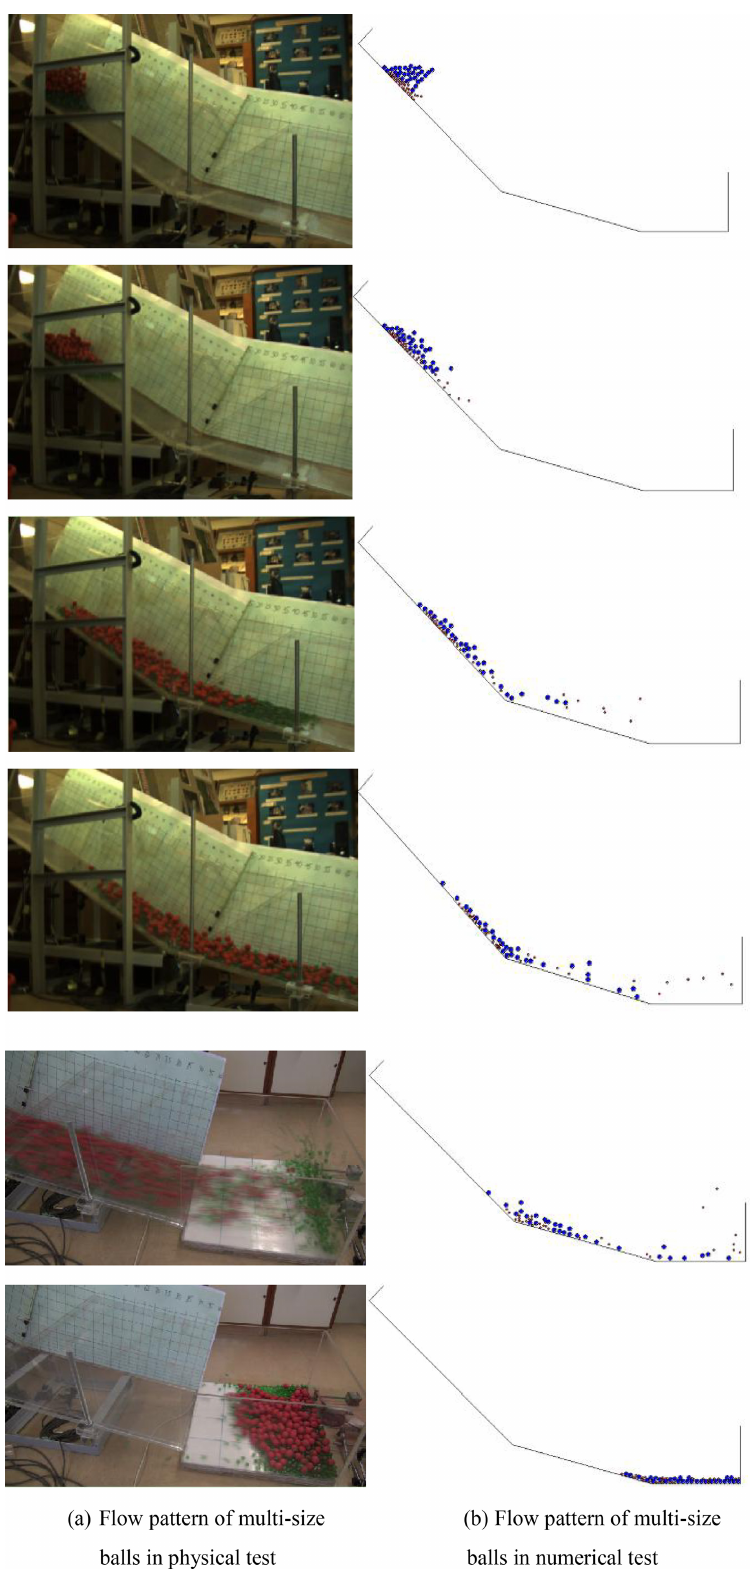
Figure 9. Flow pattern of multi-size particle flow composed of red plastic balls and green glass